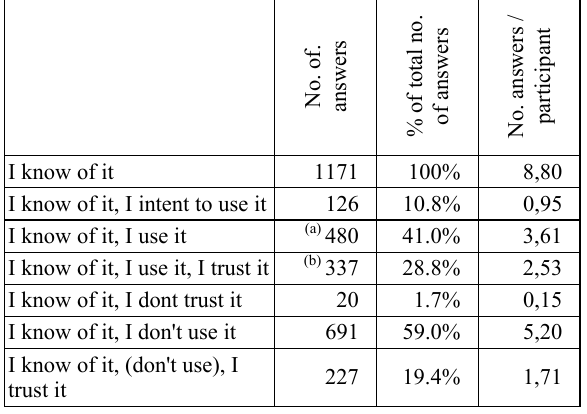
Table 3. Pearson Correlation